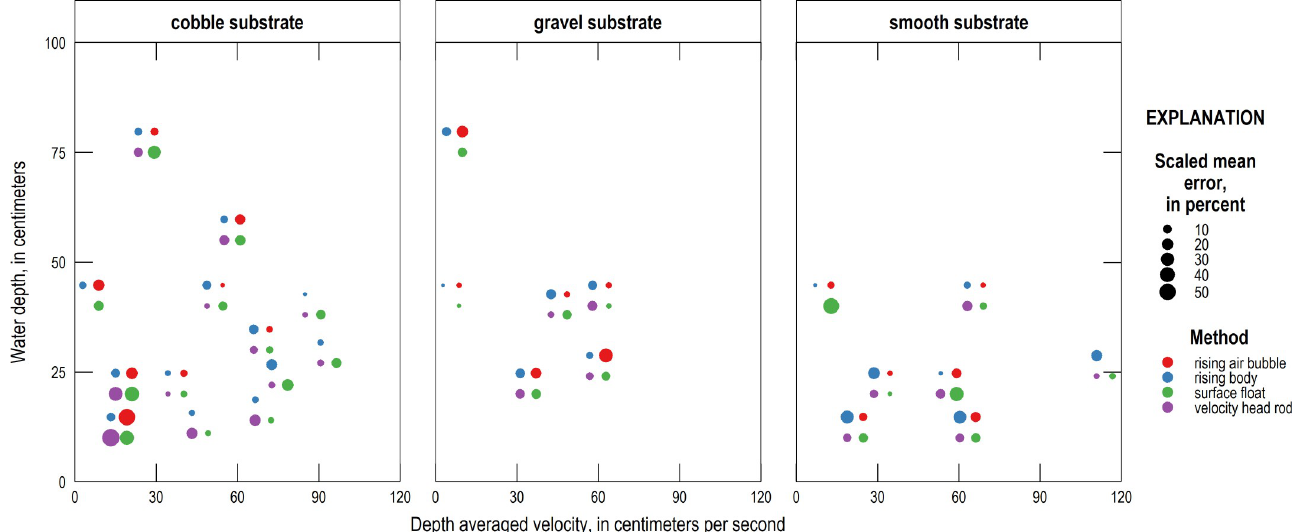
Fig 8. Accuracy, as measured by the SME, of the four alternative velocity methods under different conditions. Each color circle represents a different measurement technique and the size of the bubble represents the relative SME value, with larger circles showing less accuracy and smaller dots more. Each group of colored bubbles is centered at the coordinates representing the depth and velocity tested, however the individual bubbles are offset from this position to avoid overlap.